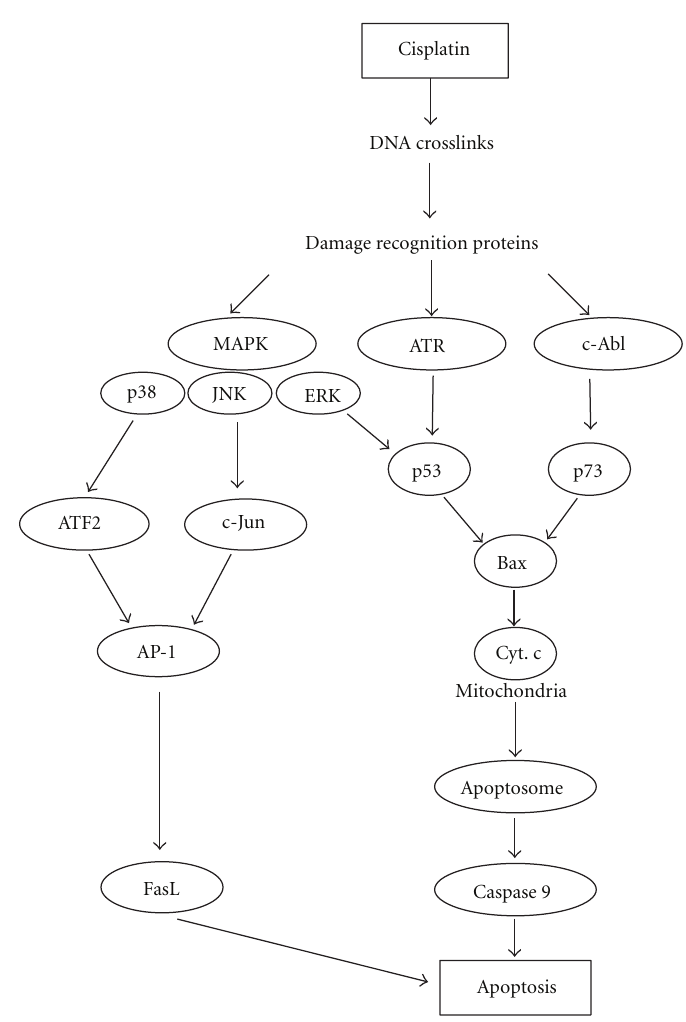
Figure 1: Signal transduction cascades mediating cisplatin-induced apoptosis. Quoted from [6] and